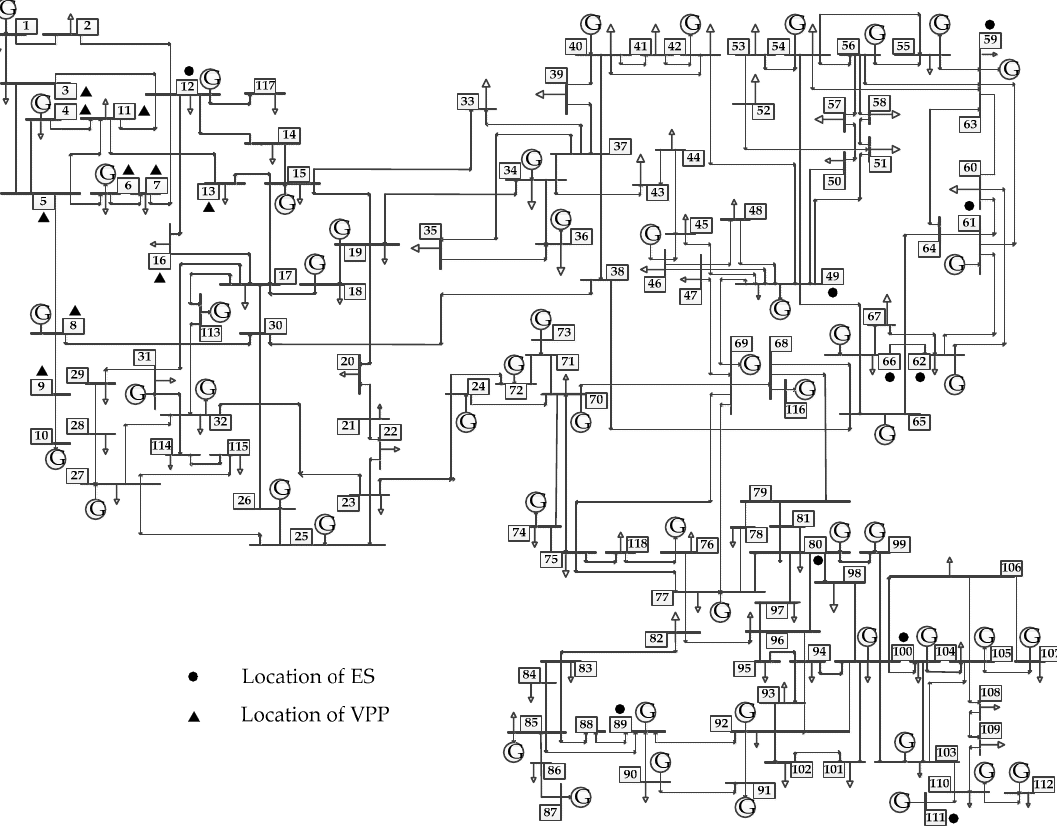
Figure 6. Topology of the modified IEEE 118-bus test system.